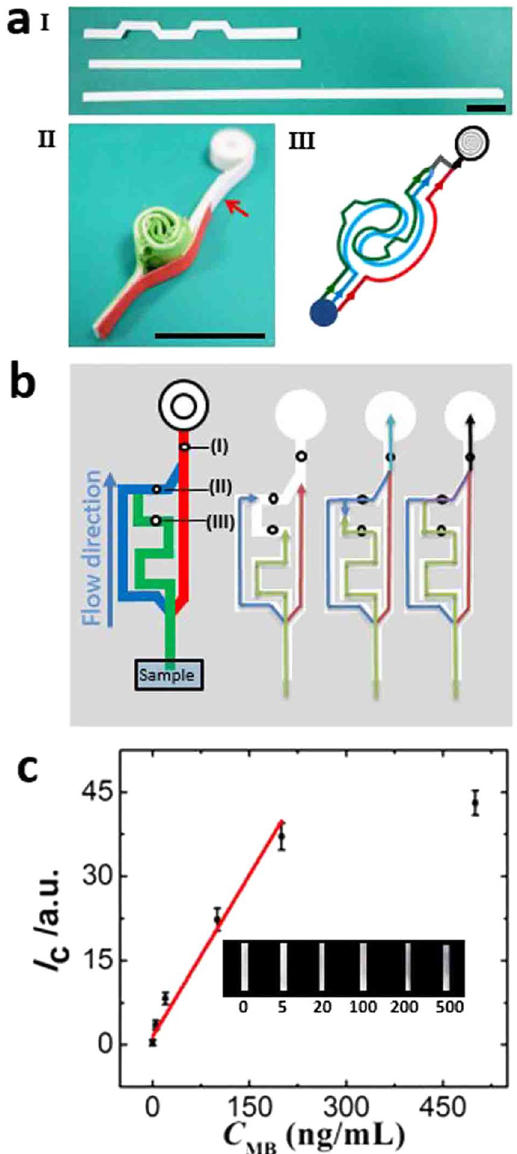
Figure 5. ( a ) Photographs of the paper strips (I) for the device fabrication and the resulted 3D vPAD (II) for myoglobin ELISA. The colors of the paper strips are from the double-sided adhesive tapes used to assemble the device. III: the resulted fluidic channels and flow direction (indicated by arrows) of aqueous sample in the device. Scale bars: 10 mm. ( b ) Schematic illustration showing the flow direction of aqueous sample in the 3D vPAD during the ELISA of myoglobin. Assays reagents (i.e. I: anti-human myoglobin antibody, II: ALP- labelled anti human myoglobin antibody, III: BCIP/NBT substrate) were preloaded on the test strips. ( c ) Color intensity ( I c) of the detection reservoir measured after completion of the assay as a function of myoglobin concentration (CMB) in the sample. The error bars represent standard deviation of 3 replicate measurements. Inset: photographs of the detection reservoirs. The concentration of myoglobin in the sample is indicated below each